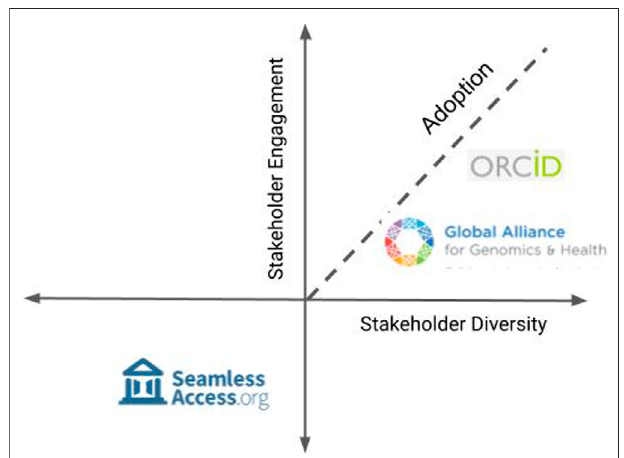
FIGURE 4 | Adoption is driven by engagement of all stakeholders. Successful multi stakeholder initiatives motivate community participation through collective social and economic